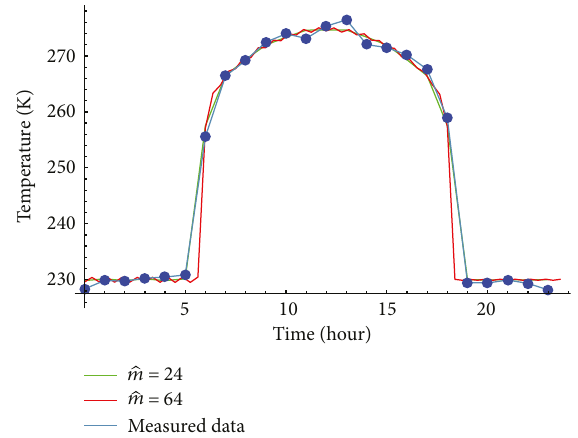
Figure 7: The comparison of the fi lm ’ s temperature for di ff erent ̂ m = 24, 64 Table 1: CPU time (in seconds) for di ff erent ̂ m .